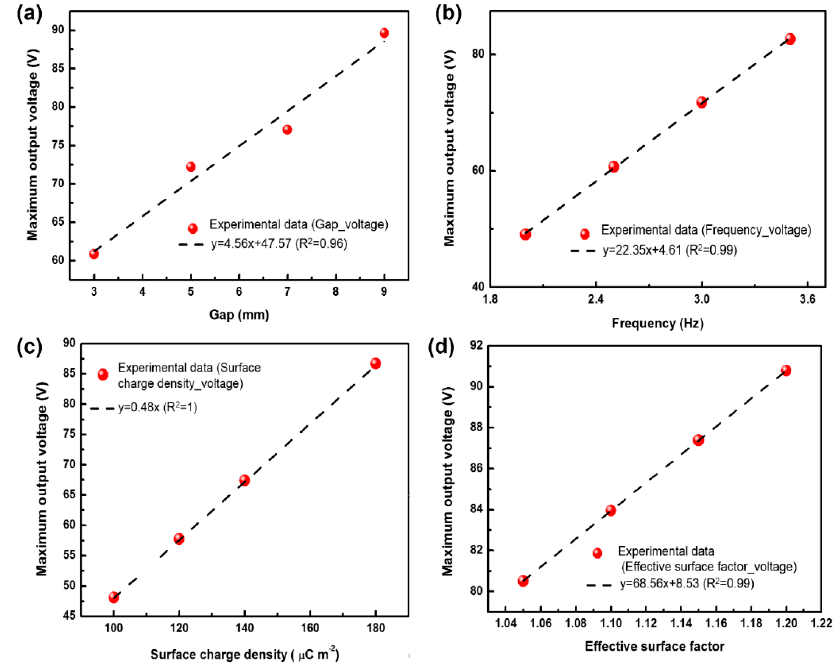
Figure 12. Relationships between maximum output voltage and gap ( a ), frequency ( b ), surface charge density ( c ) and effective surface factor ( d ).